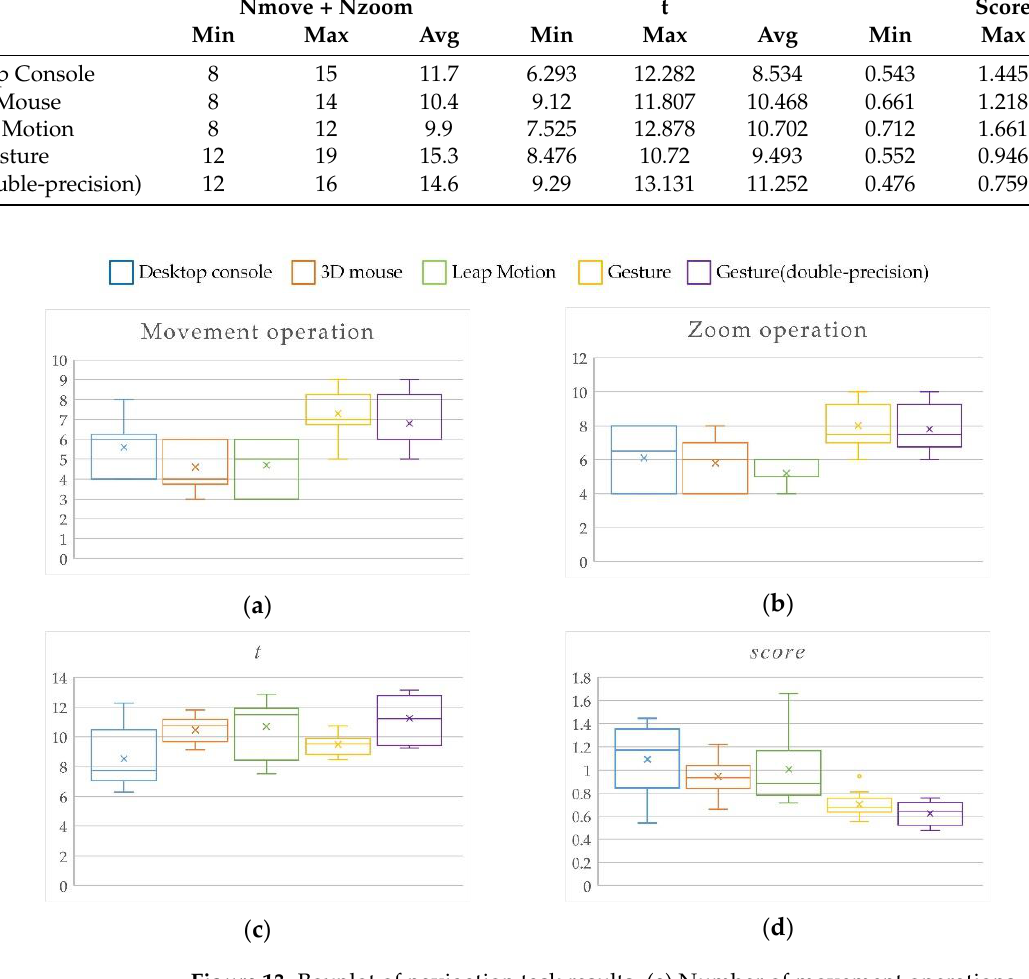
Figure 13. Boxplot of navigation task results. (a) Number of movement operations. (b) Number of zoom operations. (c) The time consumption. (d) Score of interaction operations.